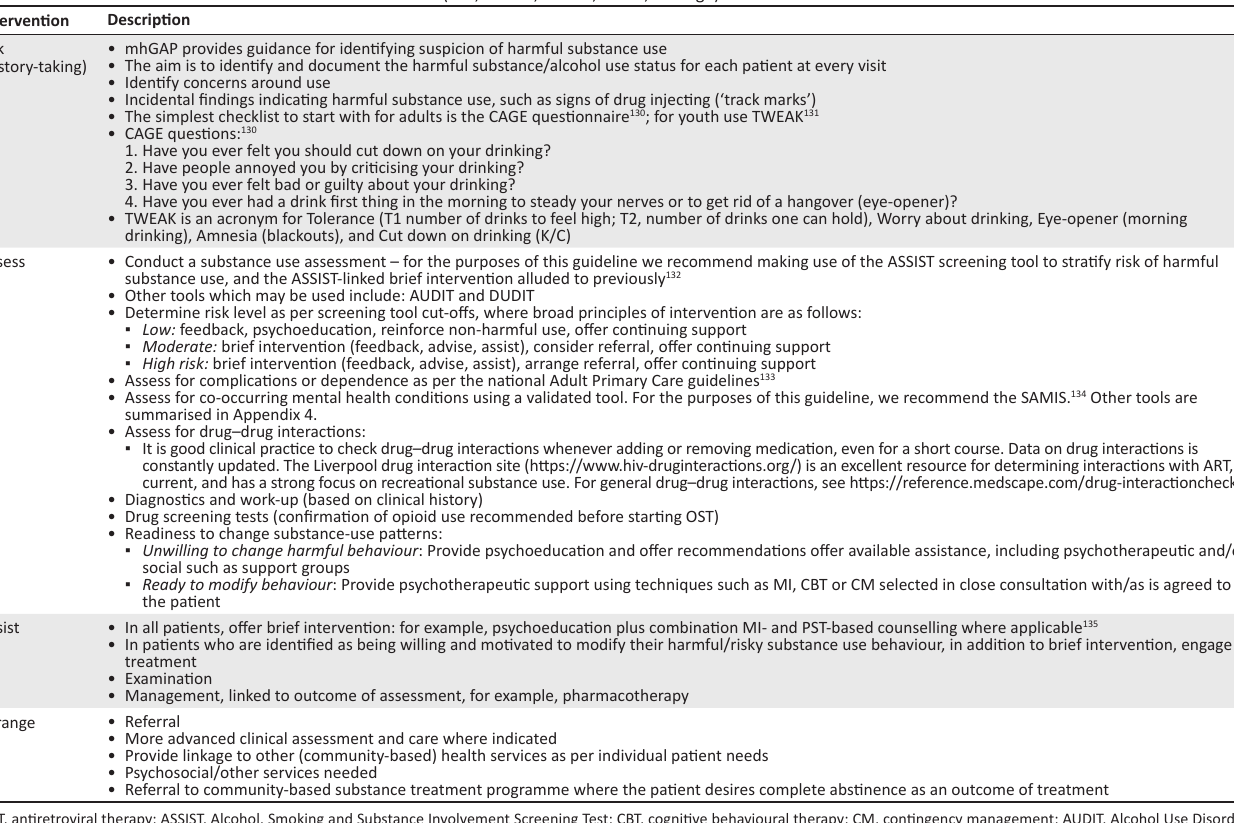
TABLE 2-A2: The first encounter – The five As of intervention (Ask, Advise, Assess, Assist, Arrange). 129 Intervention